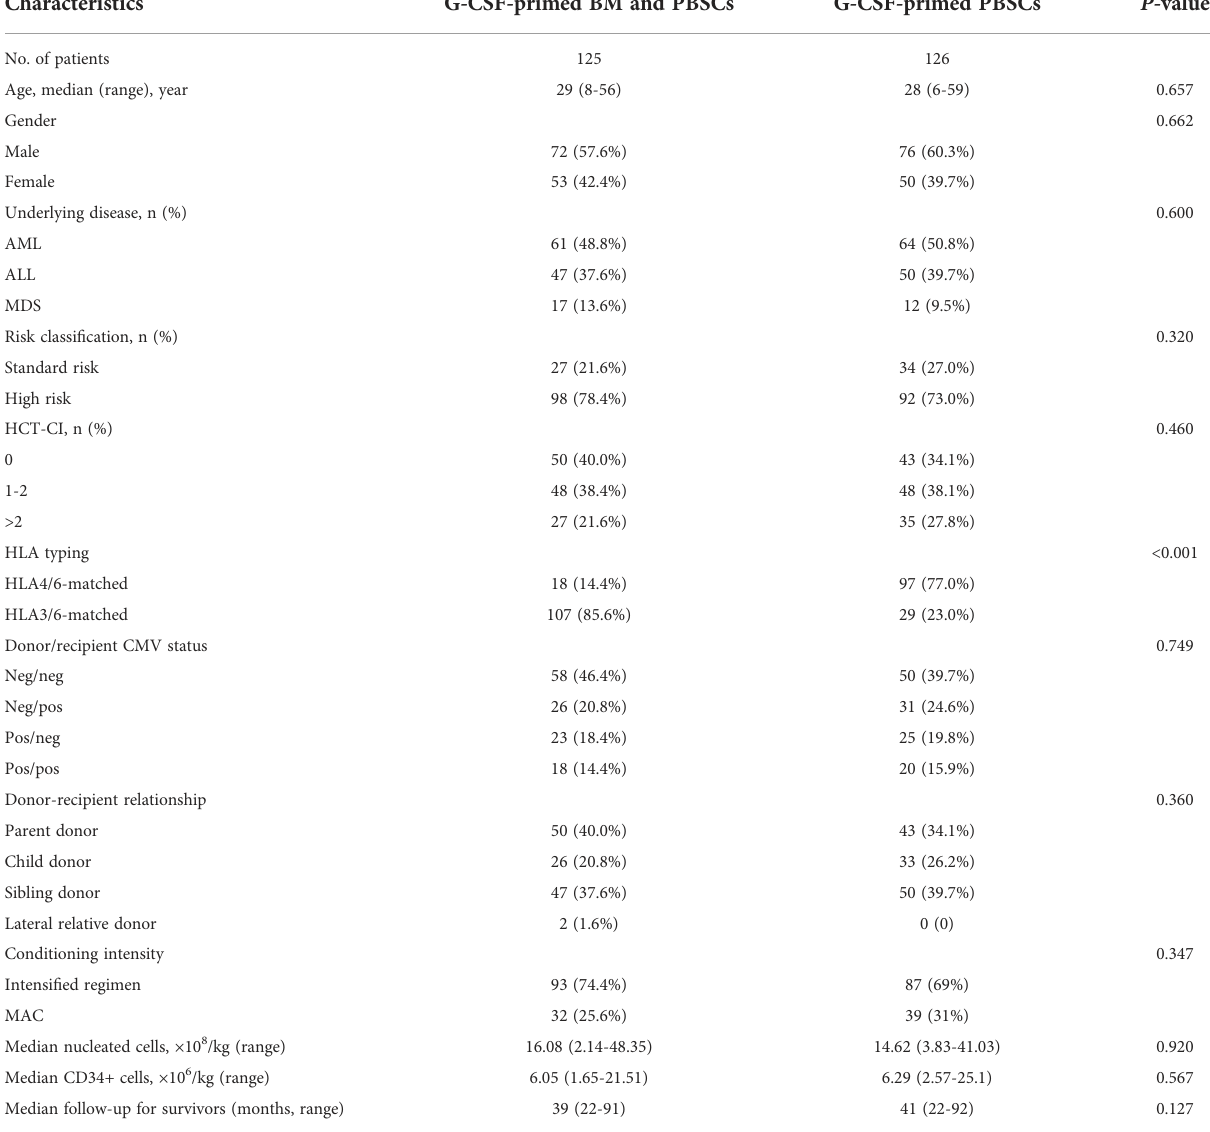
TABLE 1 Patient and transplant